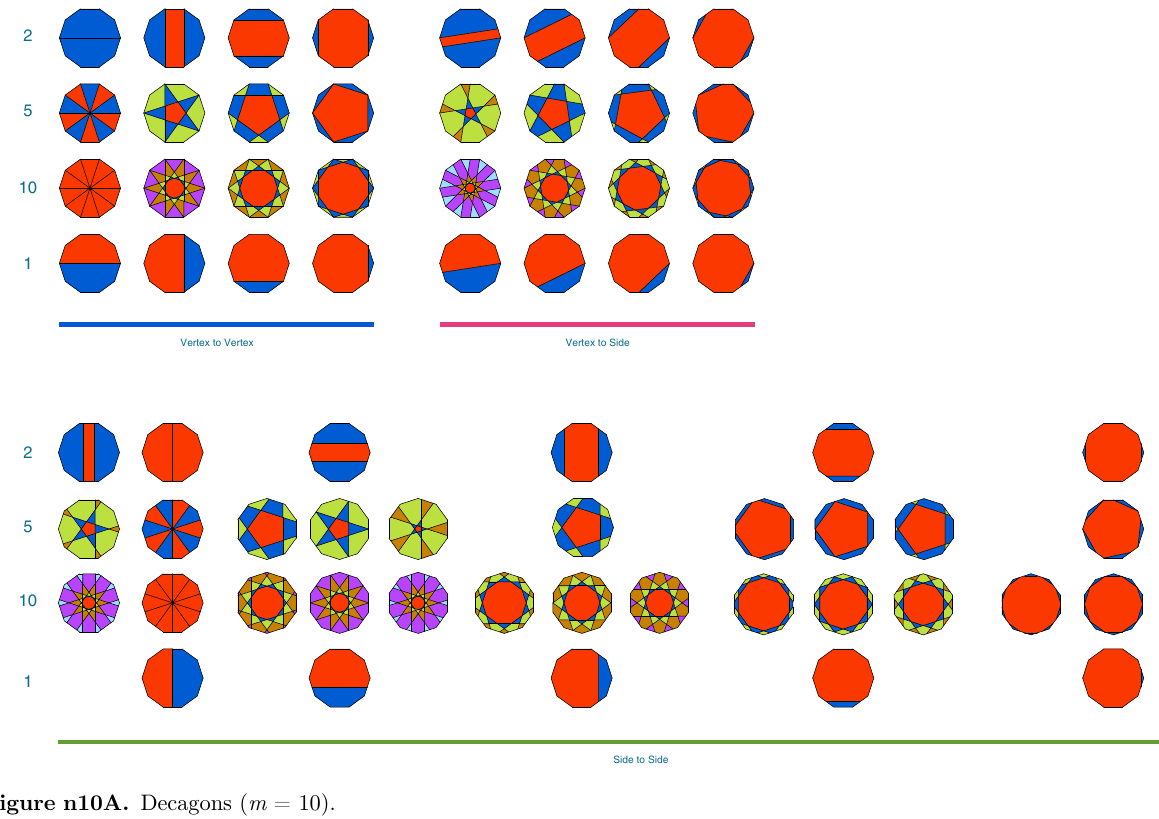
Figure n10A. Decagons ( m = 10).